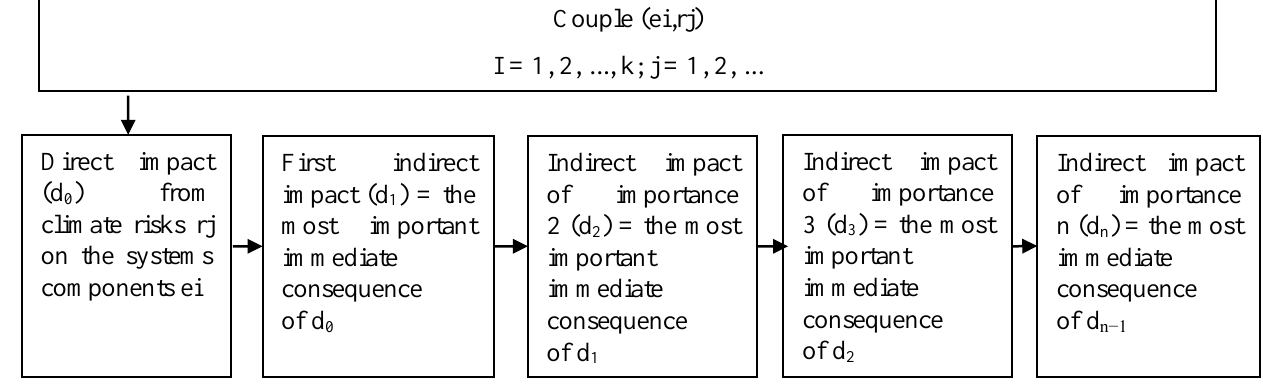
Figure 3. Approach to draw the chain of